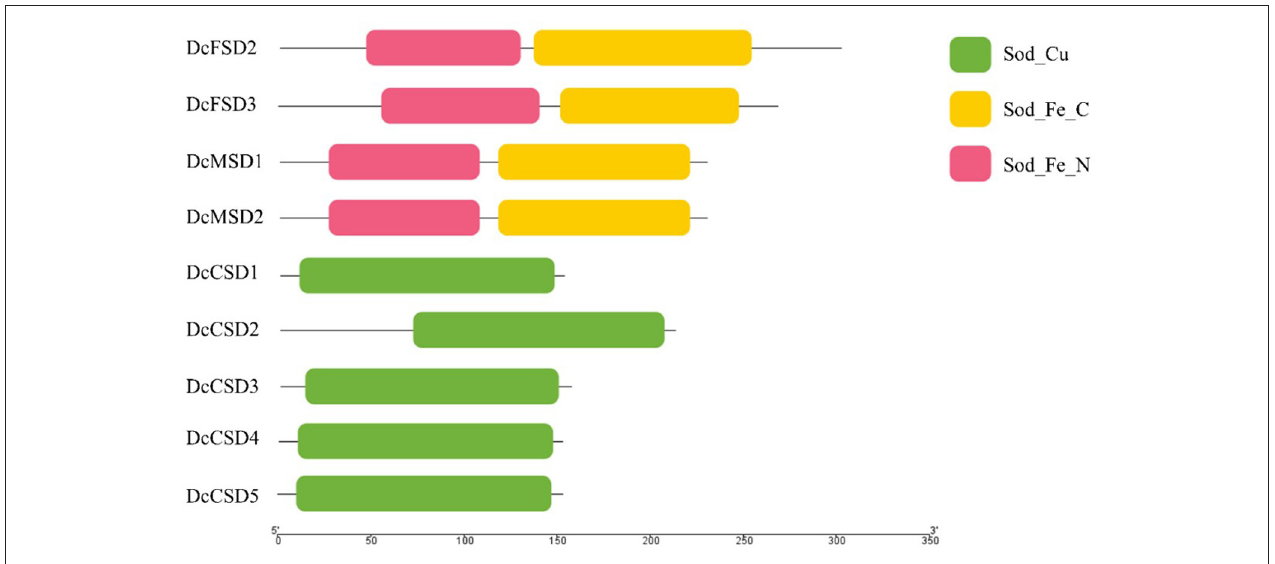
FIGURE 1 | Symbolic domain structure of Daucus carota superoxide dismutases.